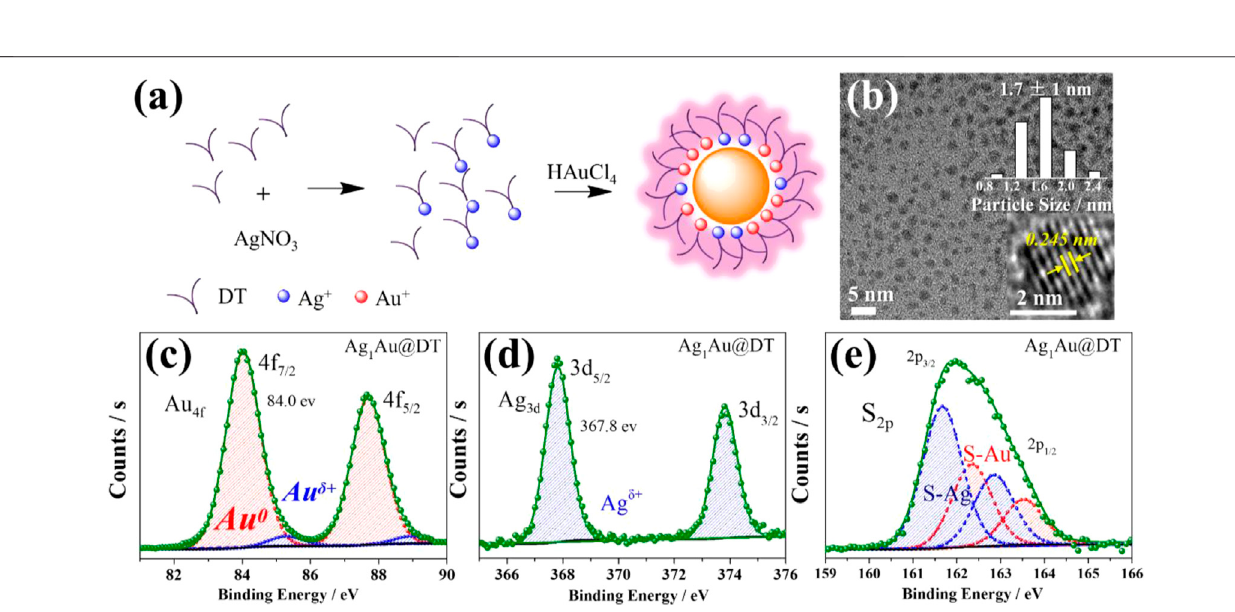
Frontiers in Chemistry |